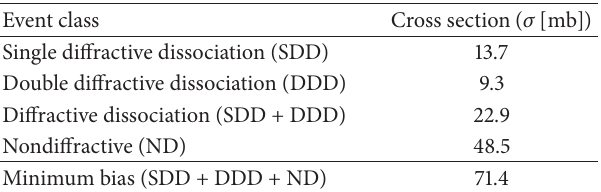
Table 1: PYTHIA 8 cross sections at √𝑠 =